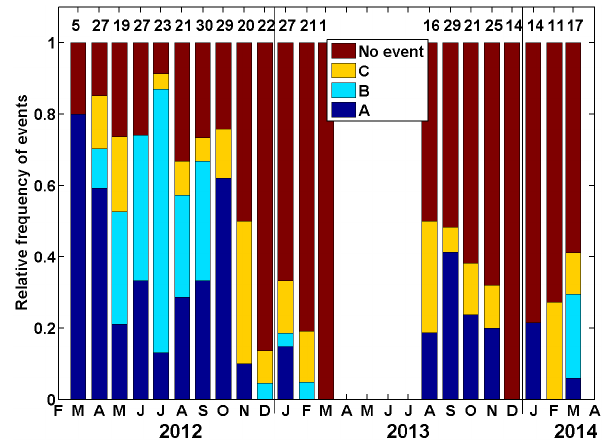
Figure 4. Overview of the occurrence of new particle formation (NPF) and nucleation event type (A, B or C event, or non-event) by month. The number at the top of the frame indicates the number of days on which data were collected and during which no instrument fault was report and no instrument maintenance was performed. The classification into event type (per the classification protocol reported in Dal Maso et al., 2005) was undertaken by a single person. Thus, while the classification is subjective, it should be consistent across the study period. Note the FMPS was not operated at the site during April–July 2013, inclusive, and thus no data are presented for that